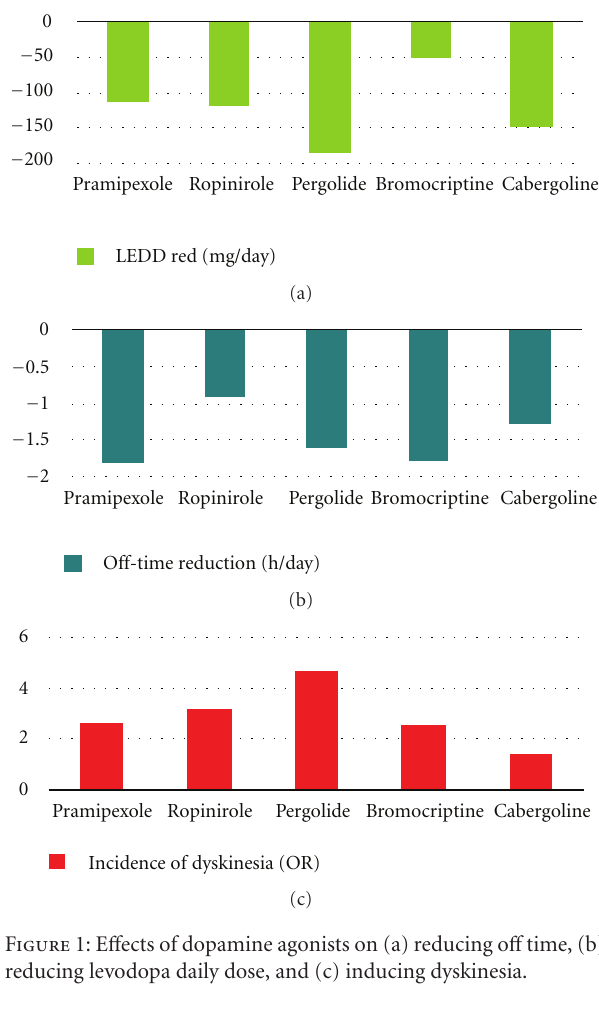
Figure 1: E ff ects of dopamine agonists on (a) reducing o ff time, (b) reducing levodopa daily dose, and (c) inducing